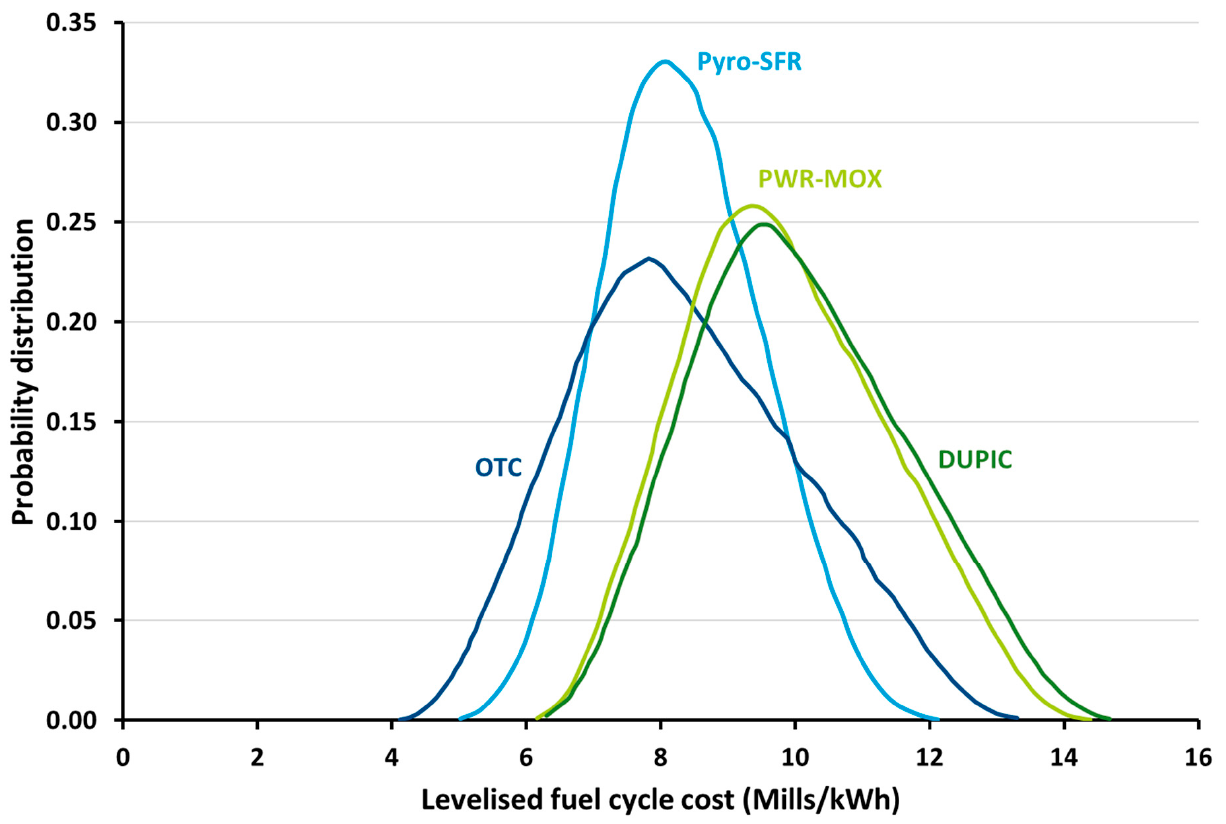
Figure 9. Probabilistic density functions for LFCC, calculated for fuel cycle scenarios by Ko and Gao [40].